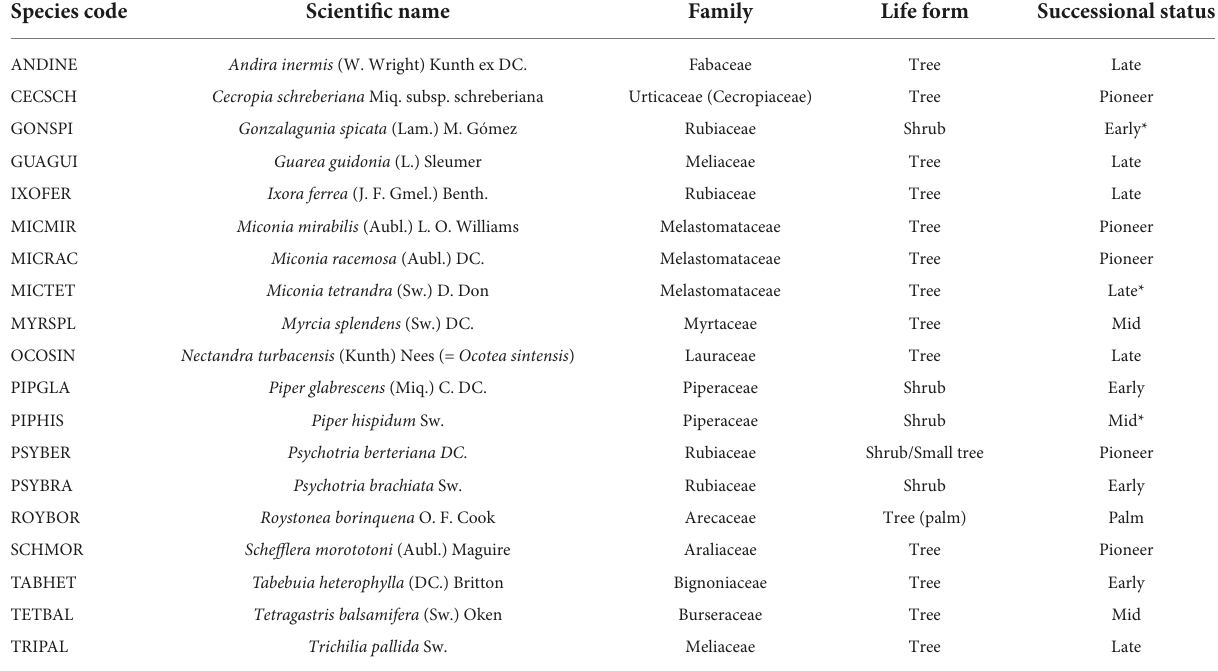
TABLE 2 Species codes with the full scientific name, family, life form, and successional status of plant species that were significantly associated with drought, hurricanes, or warming (i.e., as shown in Figure 4 ). Species